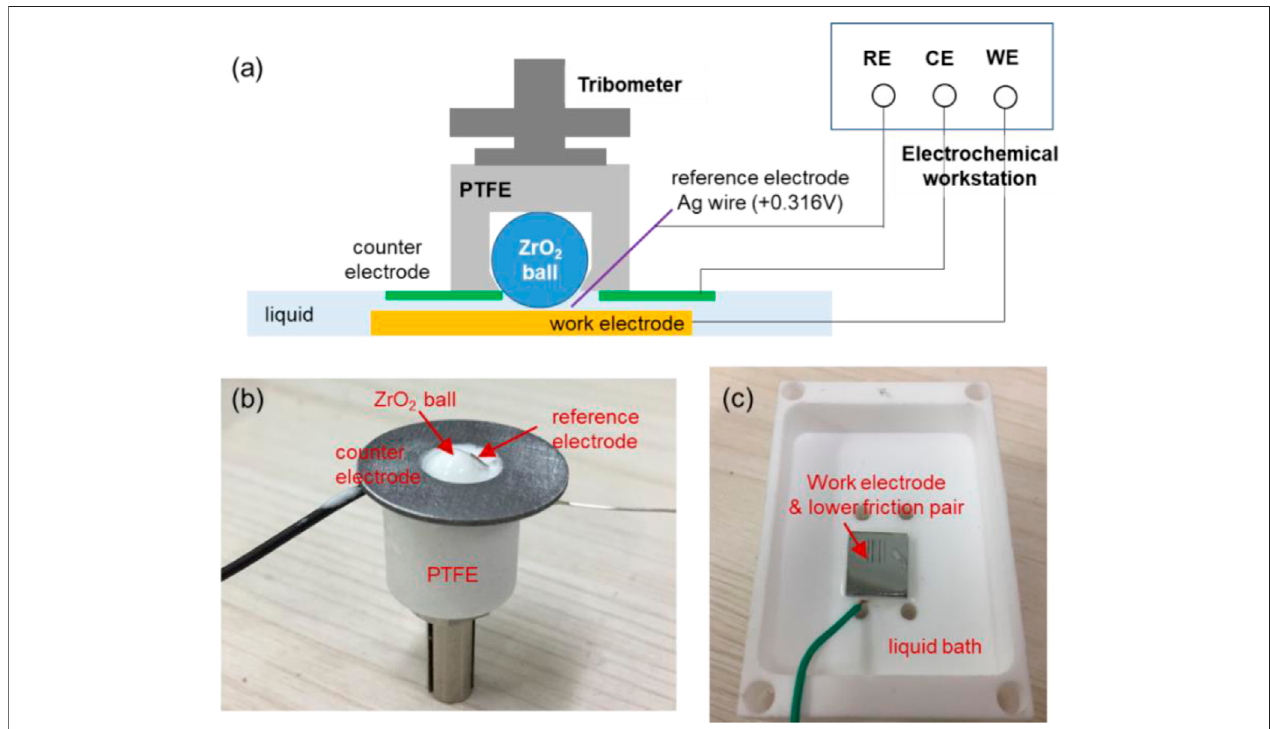
FIGURE 5 | Testing module combining a three-electrode system and a tribometer. (A) schematic diagram of the module, (B) picture of the upper friction pair section, and (C) picture of the lower friction pair section.